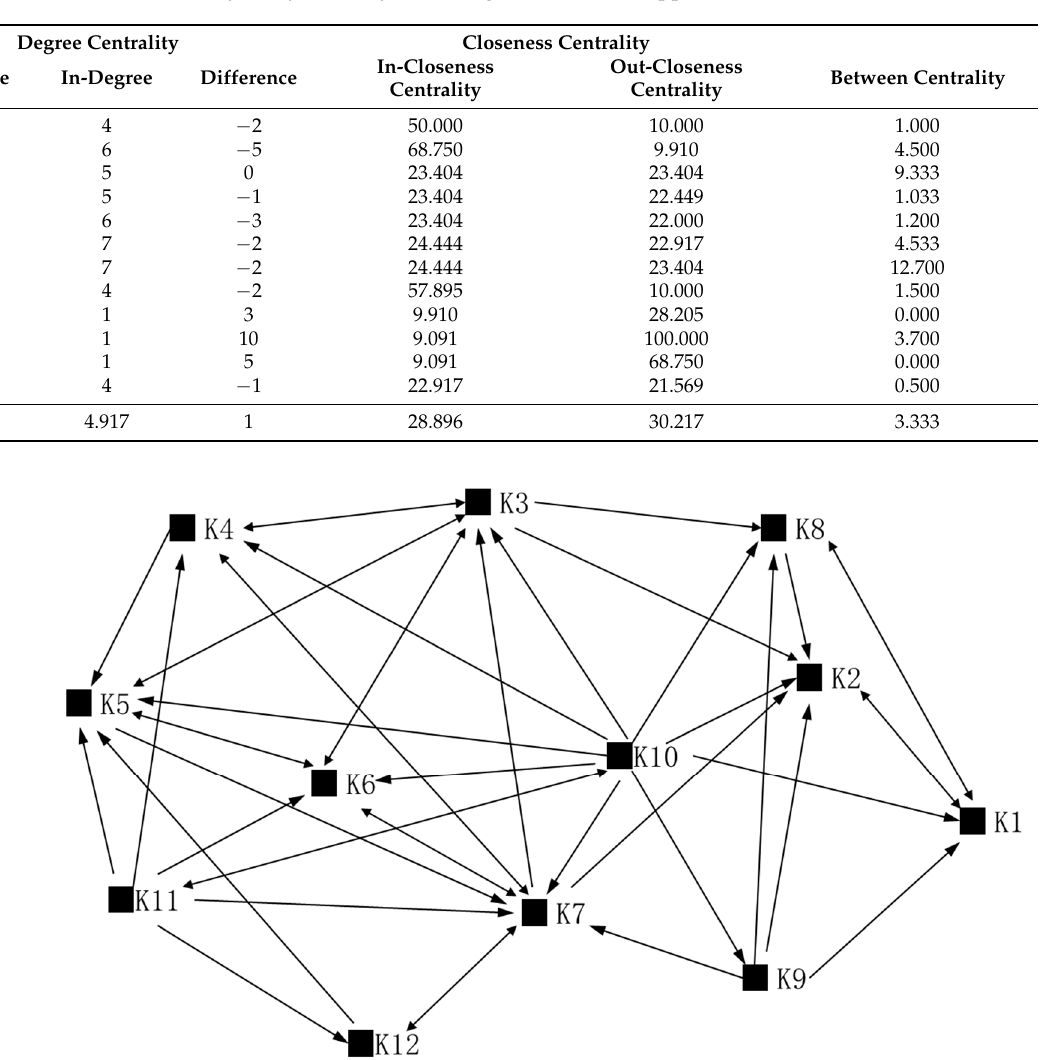
Table 7. The adjacency matrix of key hindering factors of BIM applications.